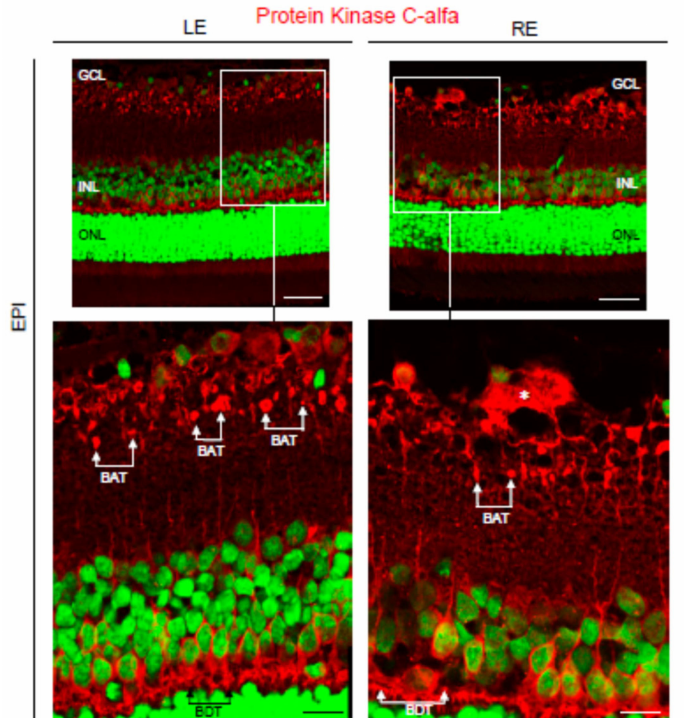
Figure 12. Calcium-dependent protein kinase C alfa (PKC α ) expression in the glaucomatous EPI model. Note the dilation (*) of axon terminals in rod bipolar cells under the EPI model. GCL: ganglion cell layer; INL: inner nuclear layer; ONL: outer nuclear layer; LE: left eye (control); RE: right eye (treated); BAT: bipolar axon terminals; BDT: bipolar dendrite terminals. Scale bar: 35.71 µ m and scale bar (inset): 13.37 µ